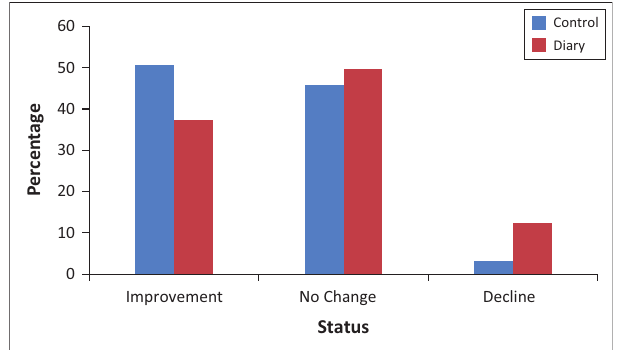
FIGURE 4: CD4+ % response at 12 months for both groups.